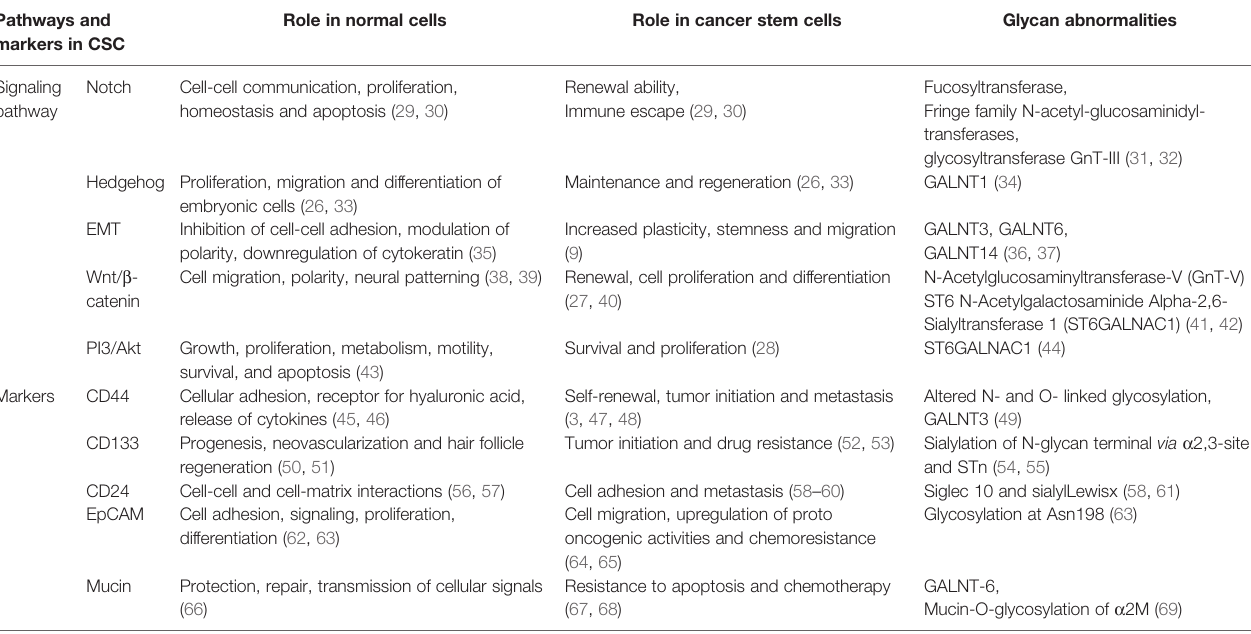
TABLE 1 | Glycan abnormalities in CSC signaling pathways and